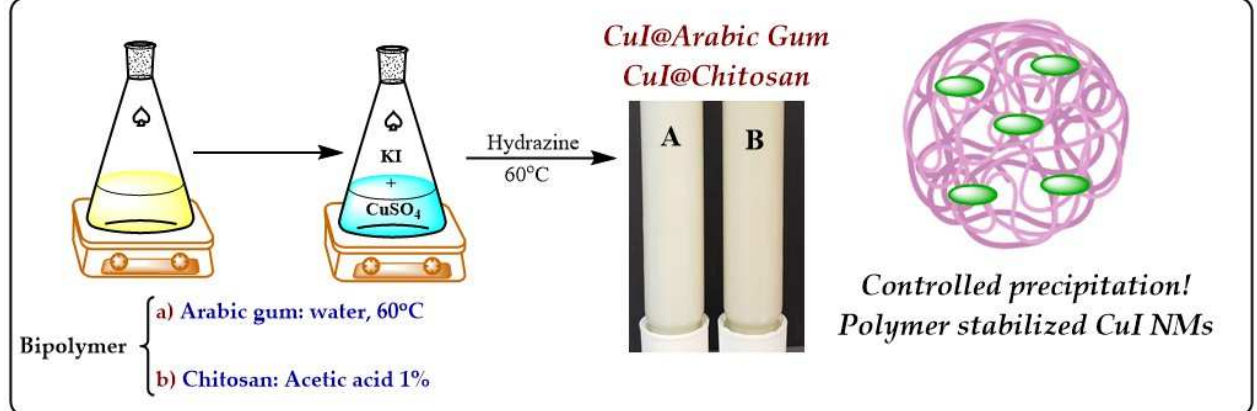
Figure 2. Synthesis of CuI nano-structured materials by a controlled precipitation method followed of reduction. Biopolymer (Arabic gum and chitosan were employed to increase colloidal stability). The materials (powders and colloids) exhibit a white color, characteristic of Cu(I)